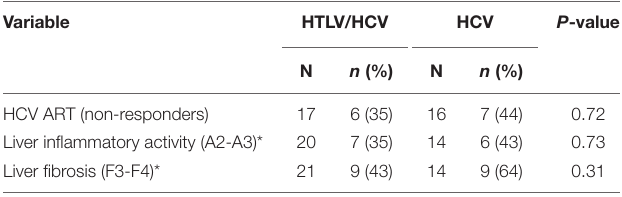
TABLE 2 | Clinical and histopathological findings of HTLV/HCV-co-infected and HCV-infected